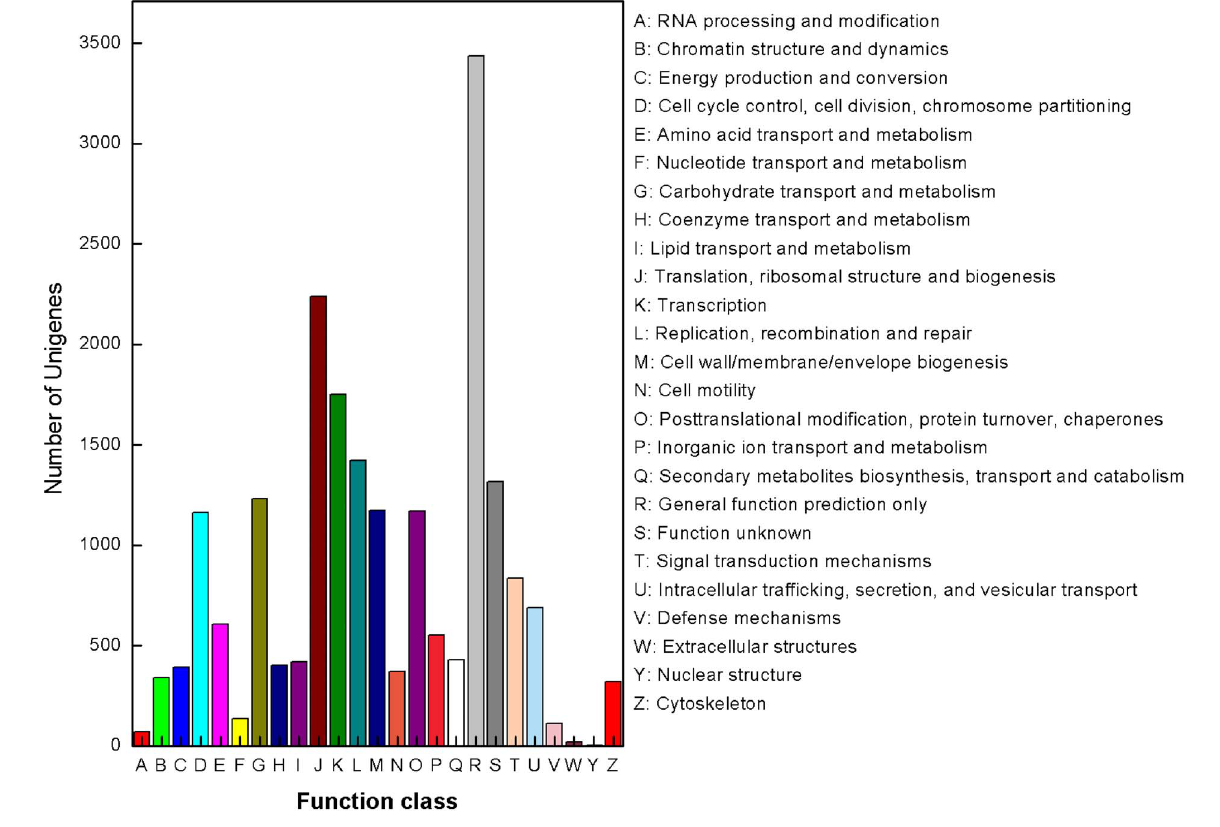
Figure 3. COG annotations of putative proteins. All putative proteins were aligned to the COG database and can be classified functionally into at least 25 molecular families.